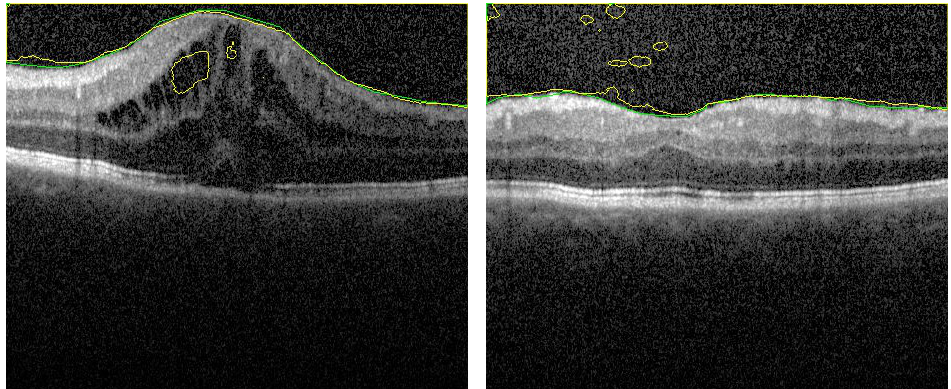
Figure 7. Segmentation sample when AP map is removed from fused images. There are artifacts in both retina layers ( left image ) and vitreous region ( right image ). These artifacts are removed when using the FI as described.